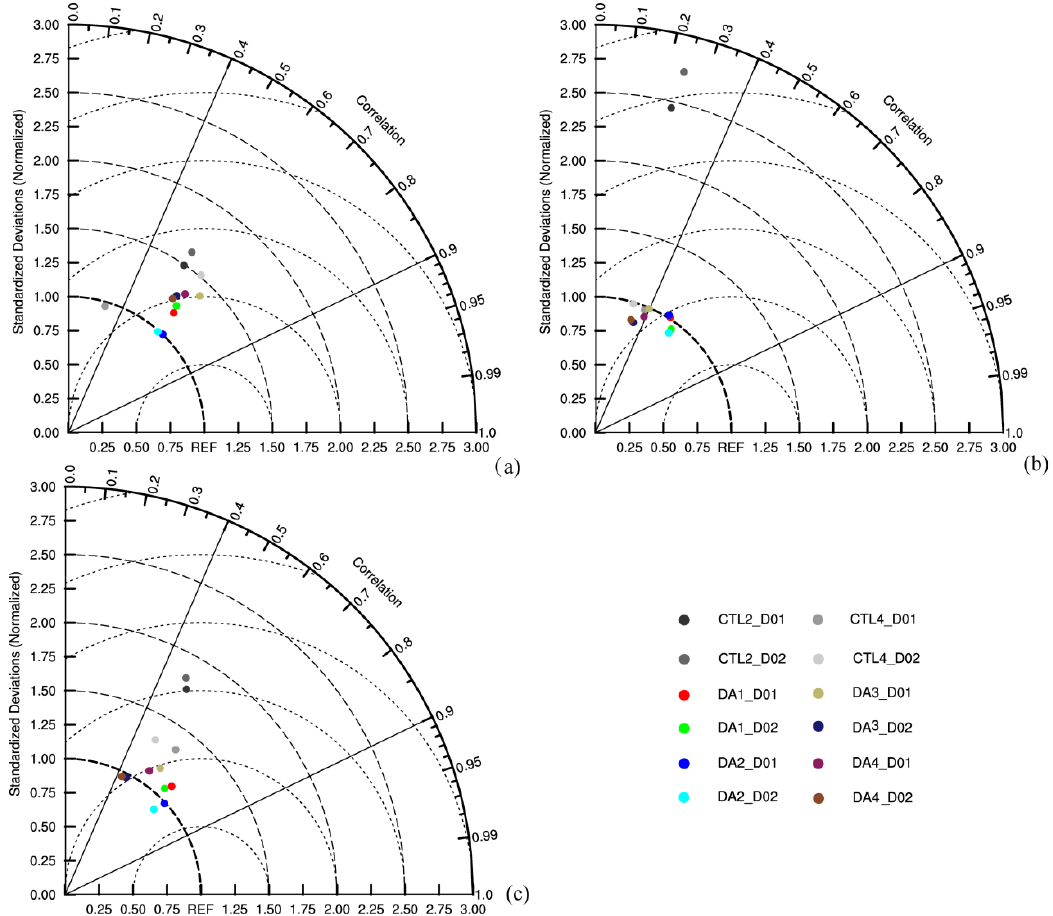
Figure 12. Normalized Taylor diagrams of the precipitation simulated by the CTL2, CTL4, and DA1-4 experiments on the first day ( a ), second day ( b ), and over the whole 48 h ( c ).